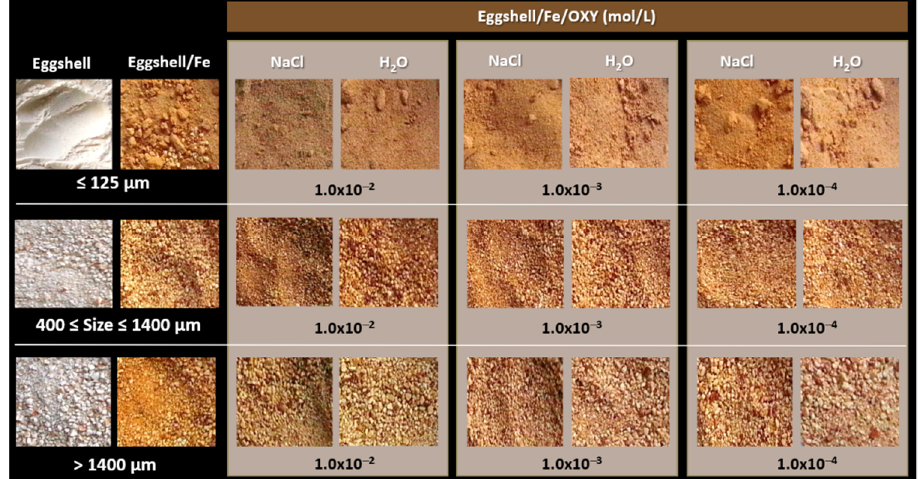
Figure 2. Pictures of the iron-modified eggshell materials, of different particle sizes, having previous incubation in water or NaCl, and undergoing reaction with antibiotic of concentrations ranging from 1.0 × 10 −4 to 1.0 × 10 −6 mol/L. 1.0 × 10 − 4 to 1.0 × 10 − 6